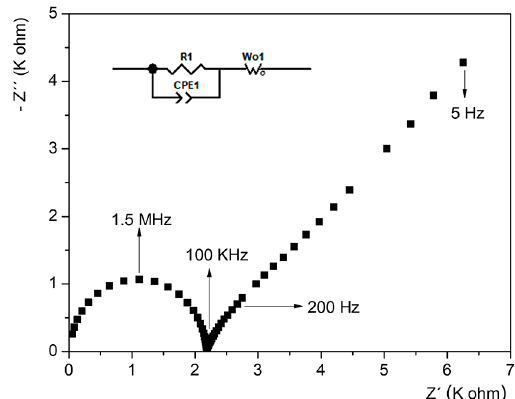
Figure 8. Equivalent circuit and Nyquist plot at room temperature of water resulting from MgAl